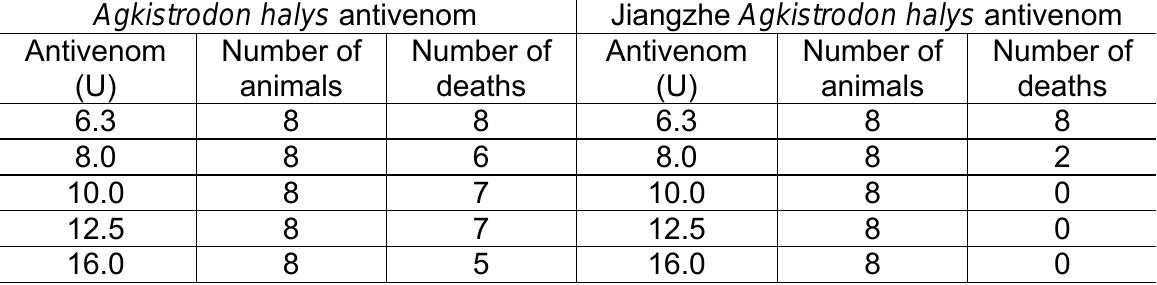
Table 5.1: Anti-lethal toxin effective dose (ED Agkistrodon halys antivenoms against 89.4 µg Agkistrodon halys venom (2.2 x LD intraperitoneally injected into